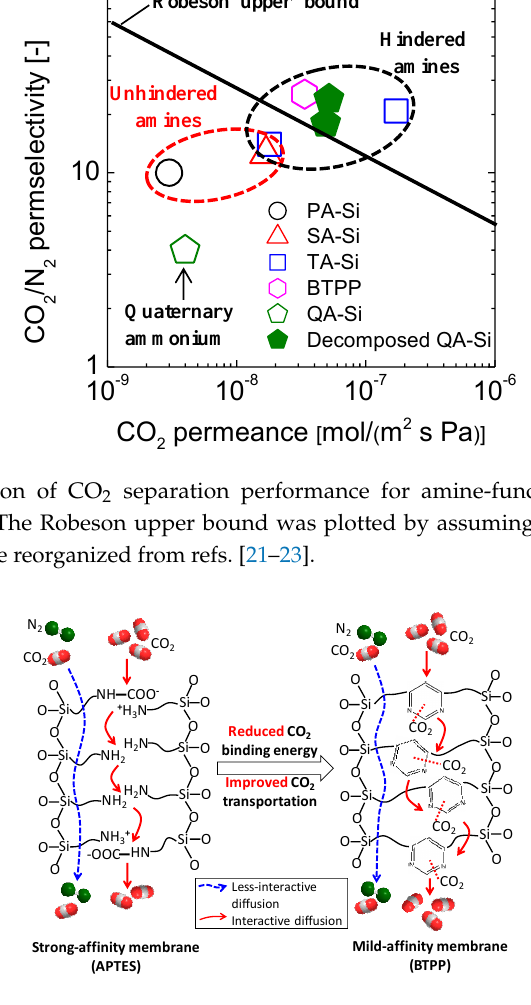
Figure 17. Comparison of CO 2 transport mechanisms across strong-affinity (APTES) and mild-affinity (BTPP) membranes. Reproduced from ref. [21] with permission. Copyright (2017), Elsevier .